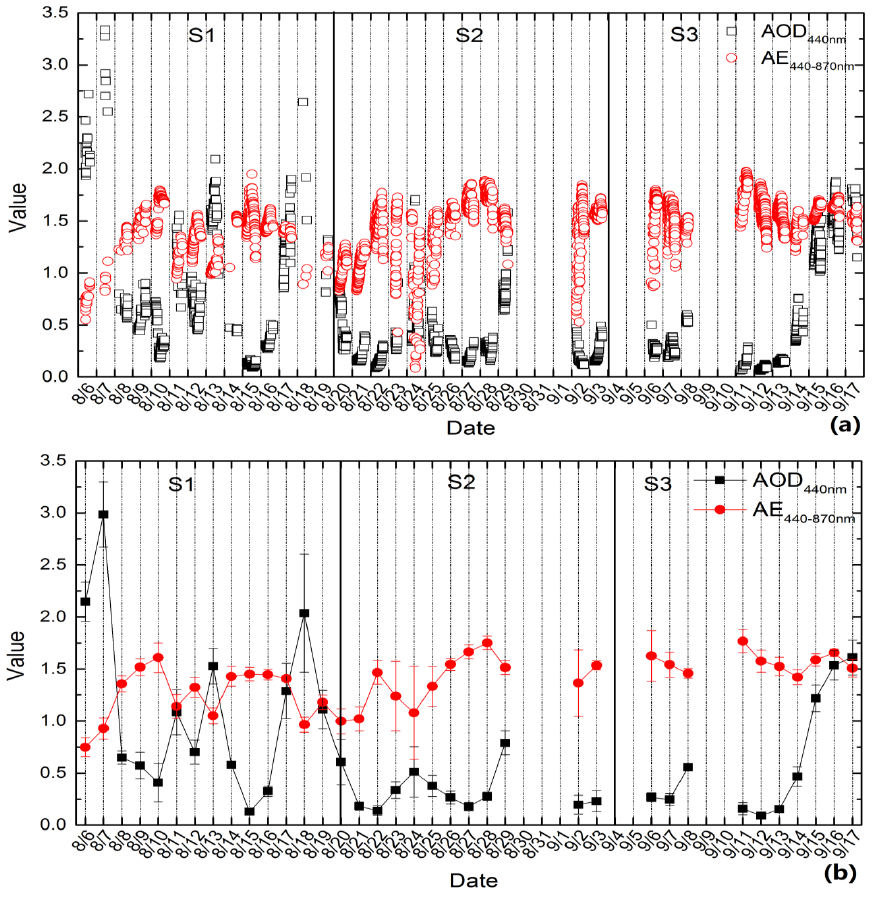
Figure 4. Daily variation ( a ) and Daily averages ( b ) of AOD and AE.